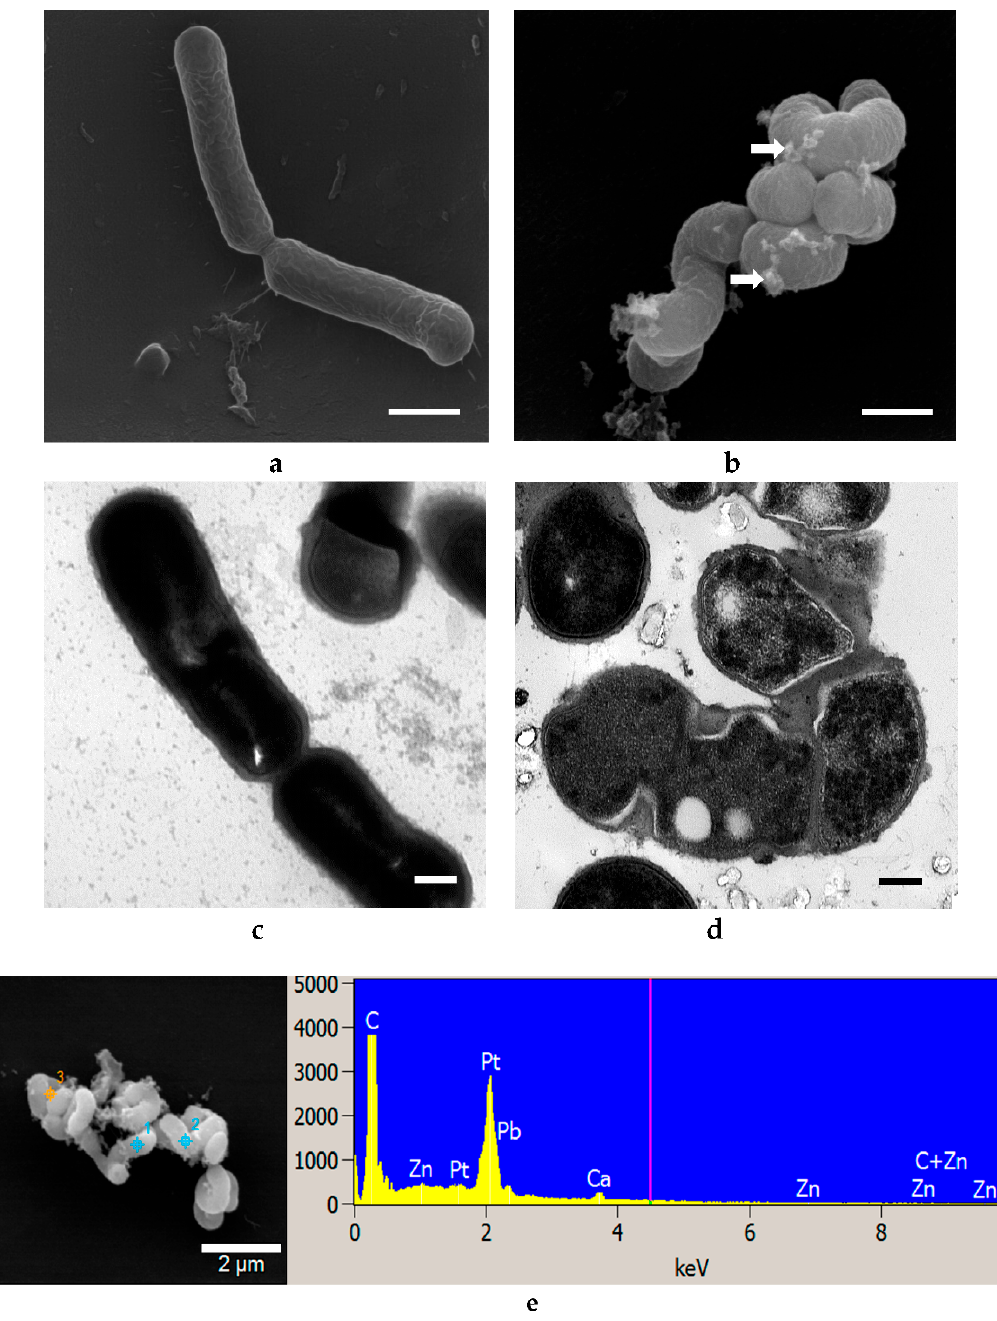
Figure 5. SEM ( a , b ) and TEM ( c , d ) images of L. acidophilus untreated with ZnO NPs ( a , c ) and treated with 20 mM ZnO NPs ( b , d ). SEM-EDS analysis shows ZnO presence on cell surfaces ( e ). White arrows indicated clusters of ZnO NPs. SEM scale bar ( a , b ) = 1 μ m, TEM scale bar ( c , d ) = 0.2 μ m.